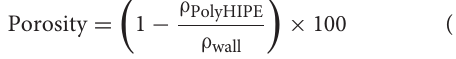
than the exact pore radius ( R ), a statistical correction